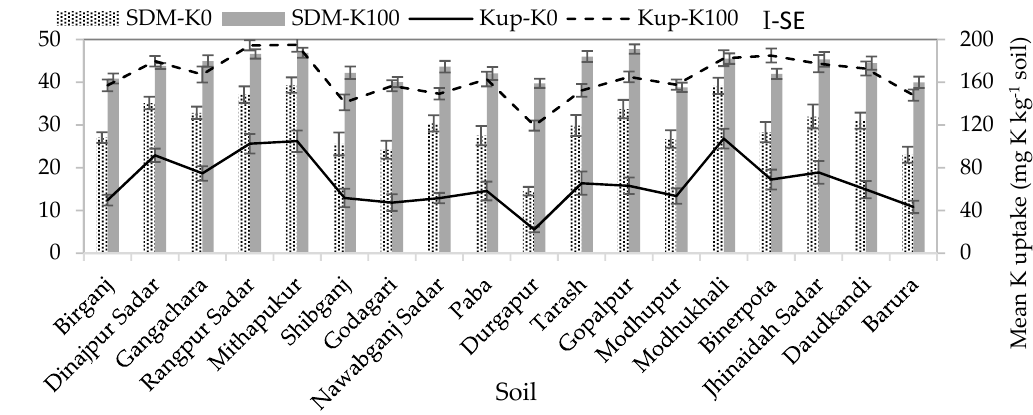
Figure 4. Trends for mean shoot dry matter (SDM) and mean K uptake over successive seven rabi maize crops in pots with K0 and K100 for 18 diverse soils of Bangladesh.